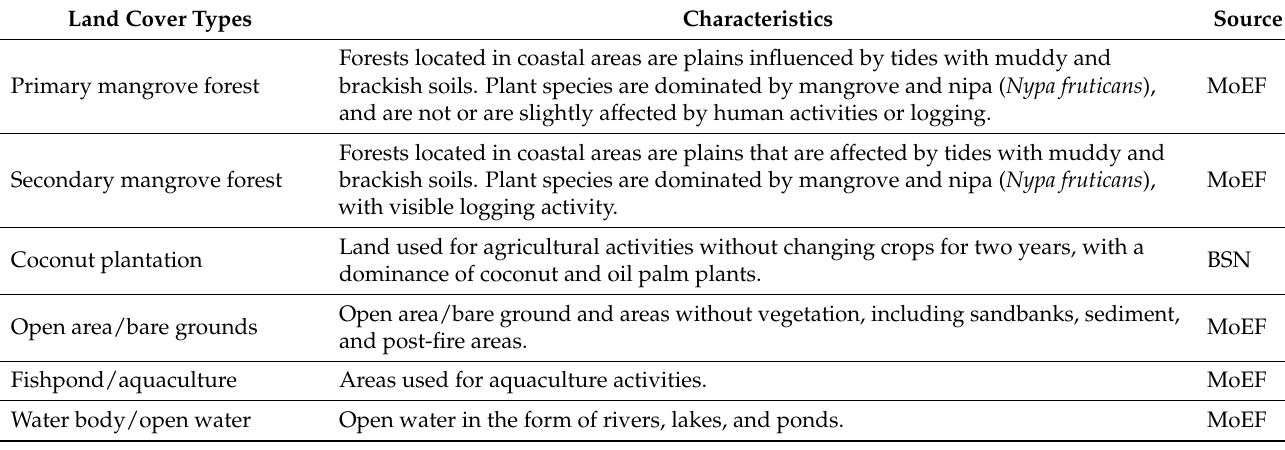
Table 3. Land cover types in ATPF and their respective characteristics. Characteristics